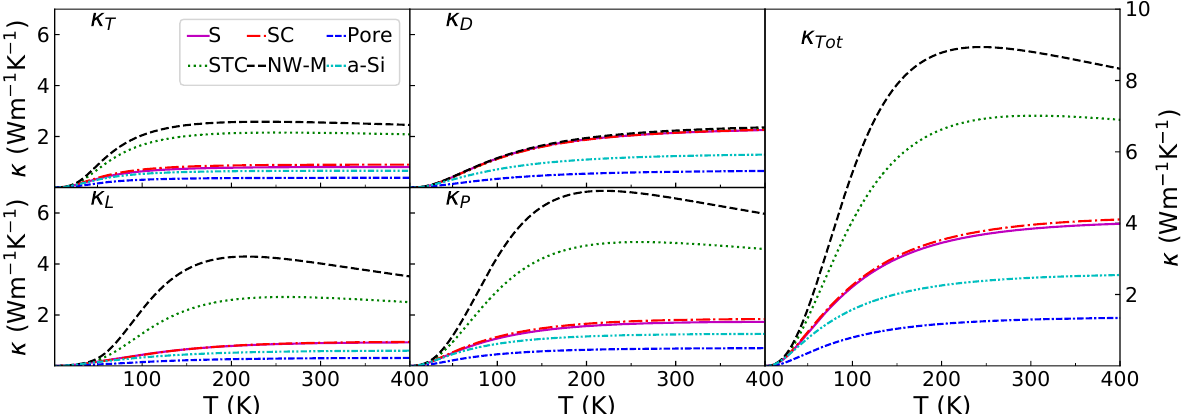
Figure 5. Different contributions to the thermal conductivity: the first column contains the contributions of the longitudinal phonons κ L ( bottom ) and the transverse phonons κ T ( top ); the second column the diffusive contribution κ D ( top ) and the overall propagative contribution κ P = κ L + κ T ( bottom ); the last columns contains the sum of the different contribution κ Tot = κ P + κ D .